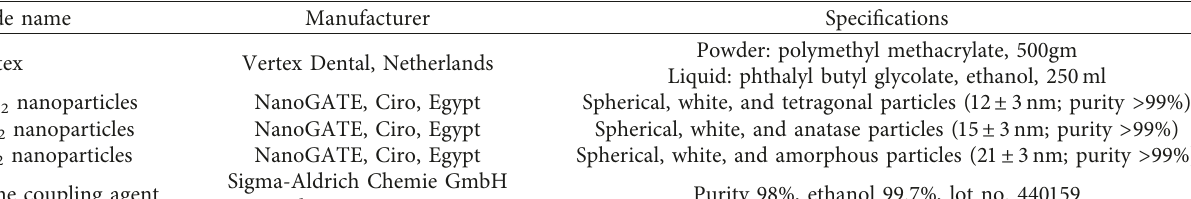
Table 1: The study’s materials.